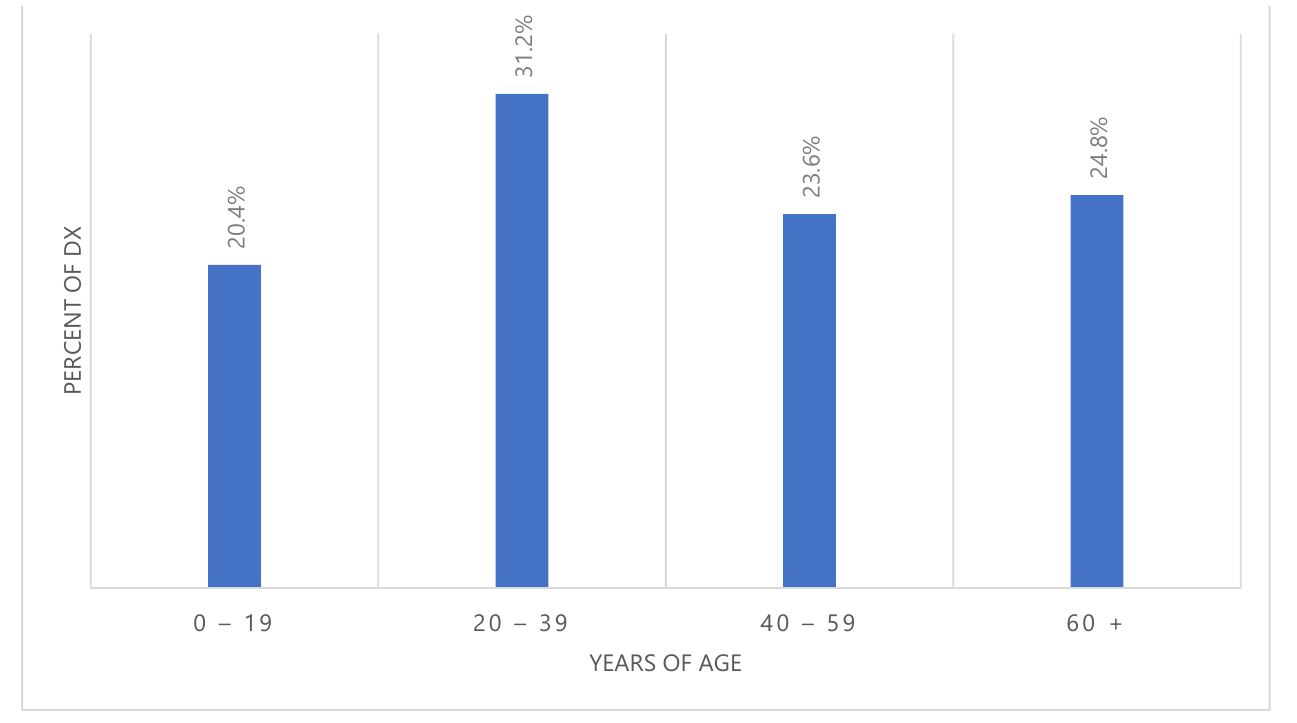
Figure 2. Distribution of ages at diagnosis, 2003–2018. Overall, 20 histological types of soft tissue sarcoma were reported during the study period. The method of first histological diagnosis was surgical material for all patients (35 by needle biopsy, 44 by incisional biopsy and 78 by excisional biopsy). Diagnoses and histological type determination were aided by IHC marker panels. Ewing sarcoma/PNET and synovial sarcoma diagnoses were confirmed by relevant gene rearrangement FISH tests in the majority of cases performed at other medical centers because this testing